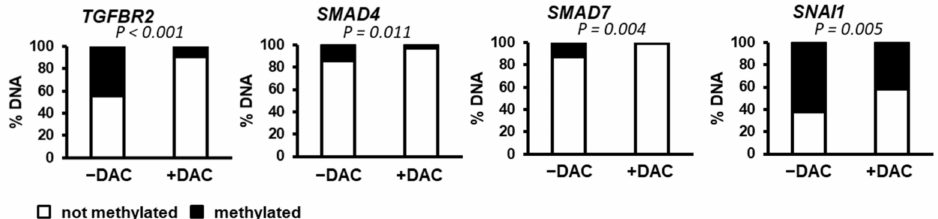
Figure 5. Methylation status of the promoters of genes associated with the TGF β pathway. DNA methylation of TGFBR2, SMAD4, SMAD7 and SNAI1 promoters was evaluated in SNU449 HCC cells in the absence (left bar, − DAC) or presence of decitabine (right bar, +DAC). p value was determined by using a chi-square test (Yates value corrected for